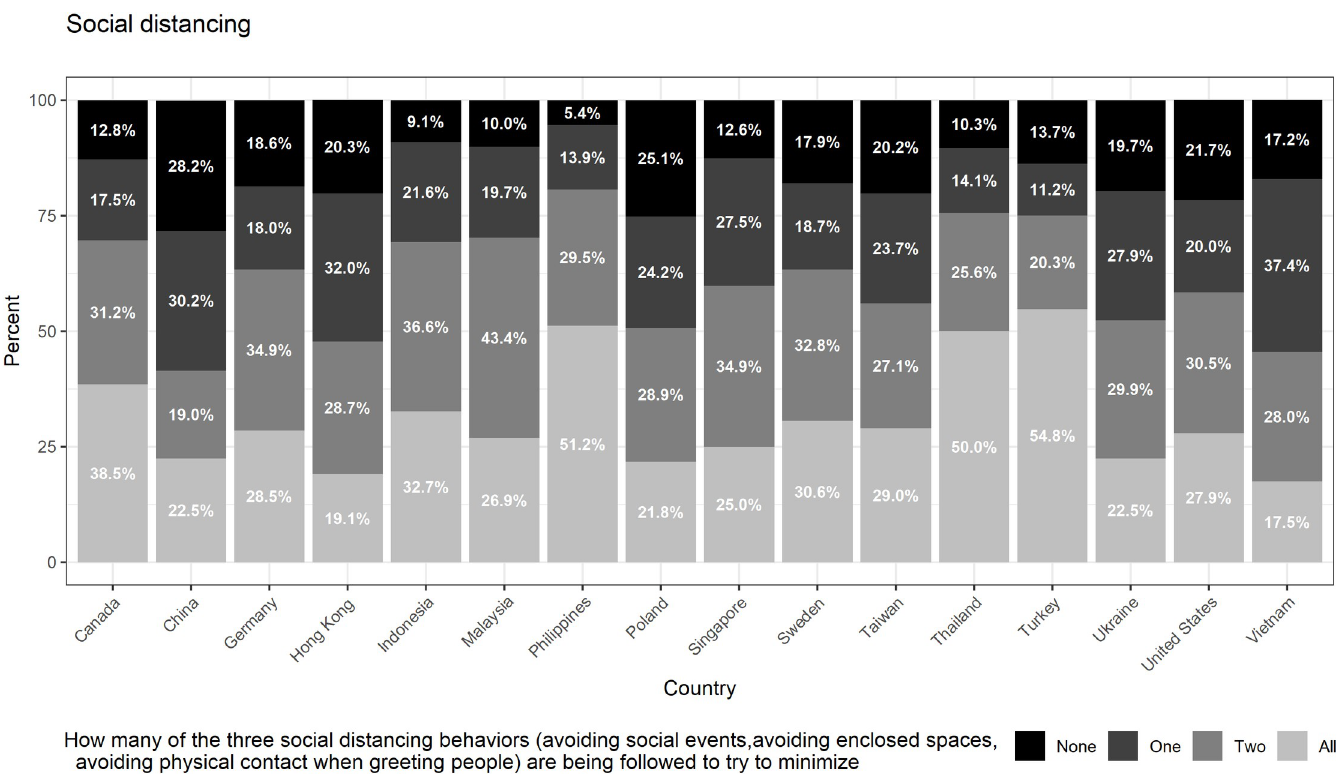
Fig 3. Self-reported social distancing by country/territory. This figure summarizes individual responses (no behaviors adopted, one behavior, two behaviors, all three behaviors), by country/territory, regarding how many of the three social distancing behaviors (avoiding social events, avoiding enclosed spaces, avoiding physical contact when greeting people) they are following to try to minimize the spread of COVID-19 in their community. Sample size by country/territory: Canada = 1077; China = 1177; Germany = 1056; Hong Kong = 582; Indonesia = 1097; Malaysia = 959; Philippines = 1160; Poland = 1107; Singapore = 541; Sweden = 1058; Taiwan = 759; Thailand = 1105; Turkey = 1108; Ukraine = 1101; United States = 1228; Vietnam = 1048.